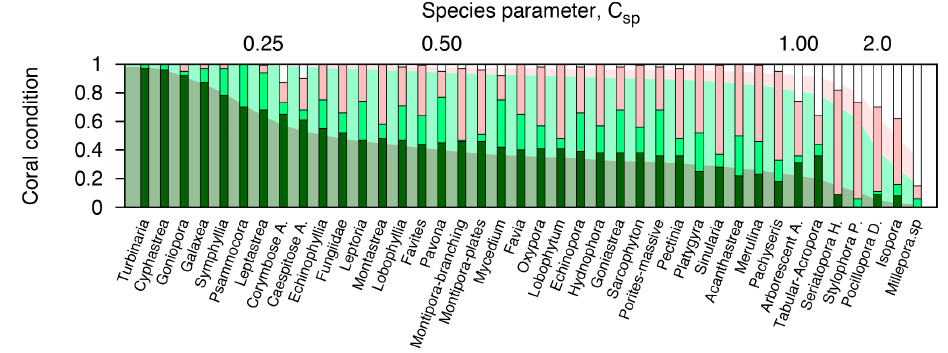
Figure 7. Comparison of the observed coral bleaching reports on the Great Barrier Reef from (Marshall and Baird, 2000) with modelled bleaching as a function of the species parameter C sp . Colour scheme as in Fig. 2.